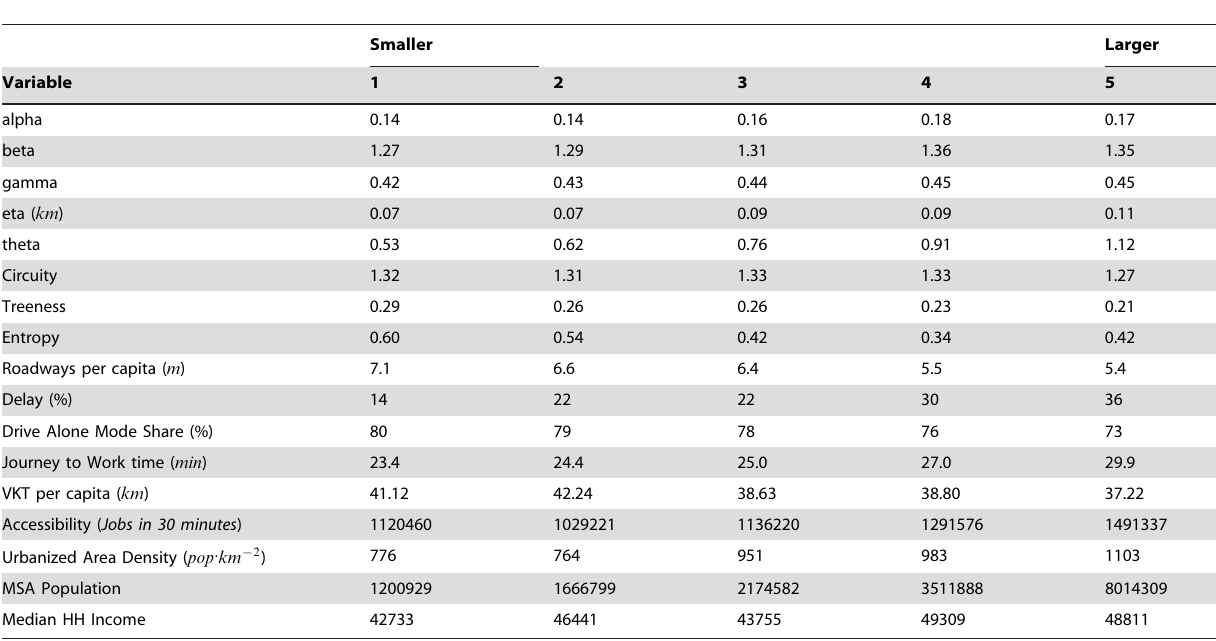
Table 1. Mean Network Structure Variables by Metropolitan Population Quintile.